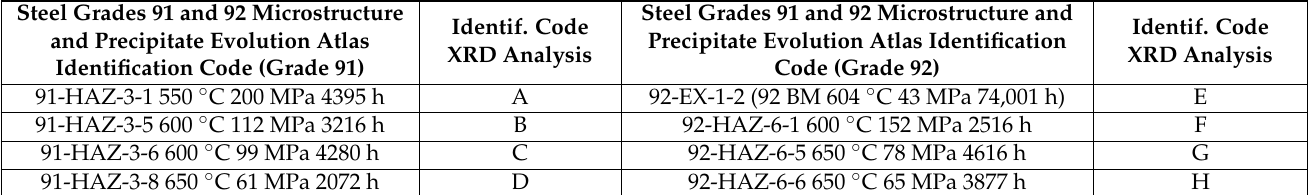
Table 7. Identification of the samples submitted to the tests.